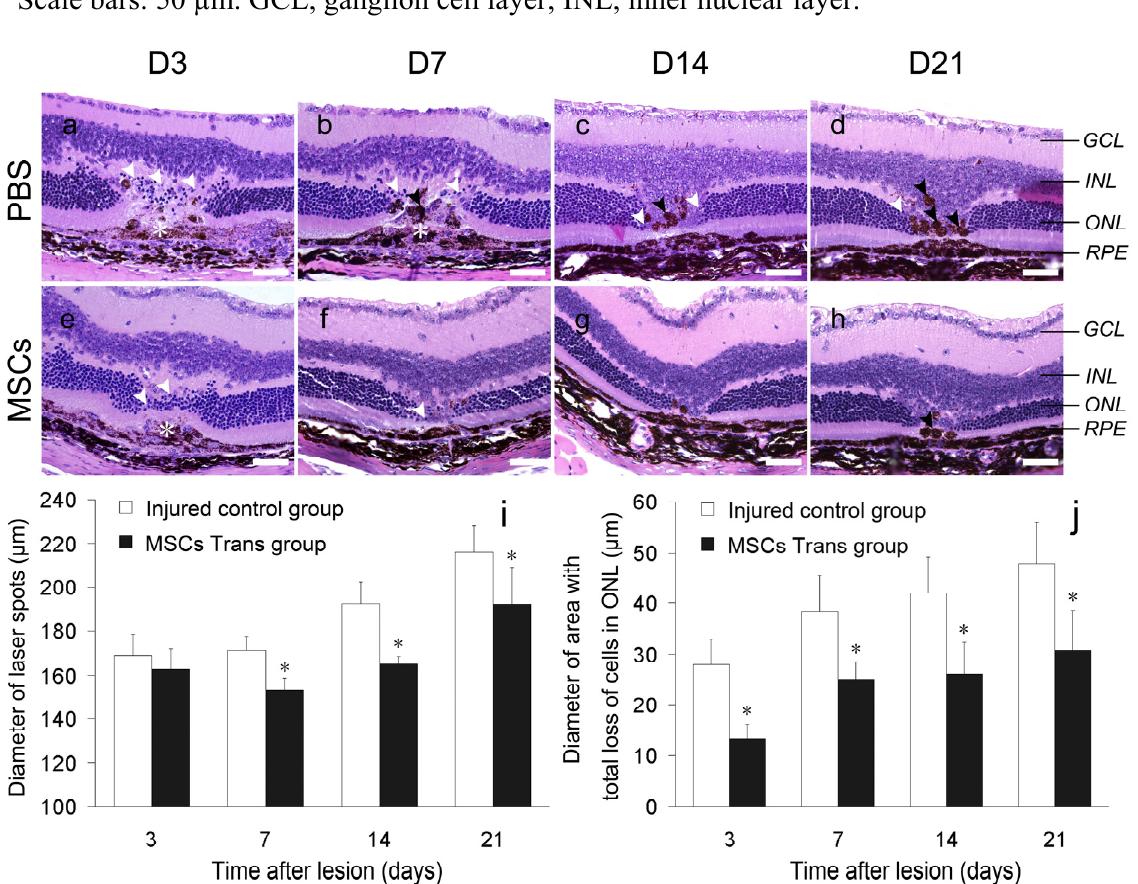
Figure 2. Histopathological changes of laser-injured retina (hematoxylin and eosin staining) and morphometric parameters of laser spots. ( a , e ) At three days after injury, the retinal pigment epithelial (RPE) layer was severely disrupted, and extensive pyknosis (white arrowheads) was seen in the outer nuclear layer (ONL). The acellular membrane (asterisk) included pigment cells and inflammatory cells in both groups at Day 3 ( a , e ), which still existed in the injured control group and disappeared in the MSC-treated group at Day 7 ( b , f ). MSC-treated retinas showed less proliferative gliocytes, pigmentation and scar tissue (black arrowheads) ( g , h ) than that in the injured control group ( c , d ) at Days 14 and 21. Values are expressed as the means ± SD ( i , j ). Asterisks denote significant differences between values obtained at the same time point in the two groups (*, p < 0.05). Scale bars: 50 µm. GCL, ganglion cell layer; INL, inner nuclear